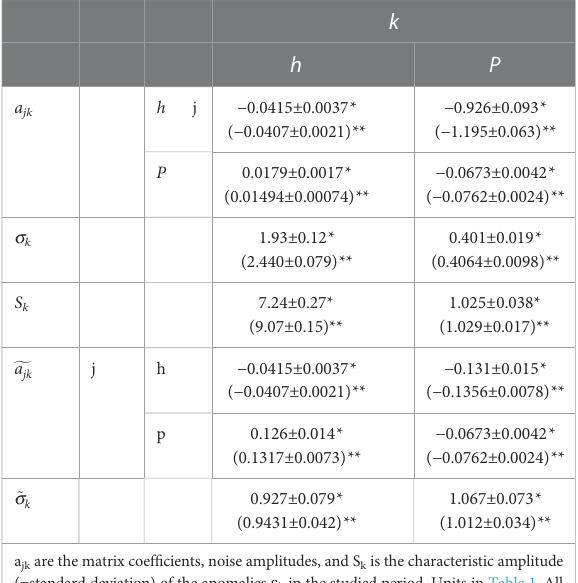
TABLE 2 Parameters (and 1-standard-deviation con fi dence intervals) obtained by the fi tting with the two-variable ReOsc+ ENSO model (Eq. 7 fi tted as explained in Section 2.4) for SODA (marked with *) and ORA-20C (with parenthesis, marked with **) reanalysis in the 1971- 2000